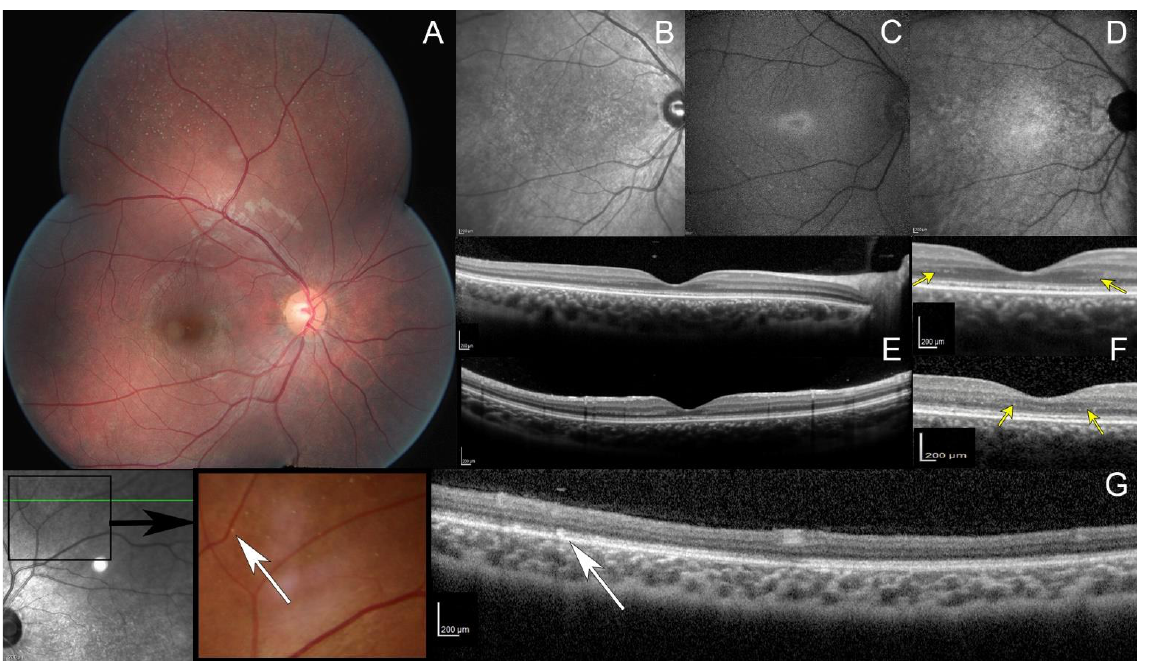
Figure 1 . Multimodal retinal imaging. ( A ) Fundus photo, multiple white dots scattered over the midperipheral retina. Note the absence of intraretinal pigment migration and the lack of retinal vessel attenuation. ( B ) Infrared reflectance image, macular granularity. ( C ) Short-wavelength fundus autofluorescence imaging obtained with significant averaging due to the generalized reduced autofluorescence, small peri-foveal hyperautofluorescent ring with indistinct borders. ( D ) Near infrared fundus autofluorescence, small hypoautofluorescent dots. ( E ) and ( F ) spectral domain optic coherence tomography (SD-OCT, top: horizontal scan; and bottom: vertical scan), hypo reflective and fragmented ellipsoid zone with no interdigitation zone; preserved outer nuclear layer thickness with an unusual hyper reflective band on both sides of the fovea (yellow arrows). ( G ) OCT (scan passing through white dots, white arrows), hyperreflective dots above the retinal pigment epithelium with a focal interruption of the ellipsoid zone.